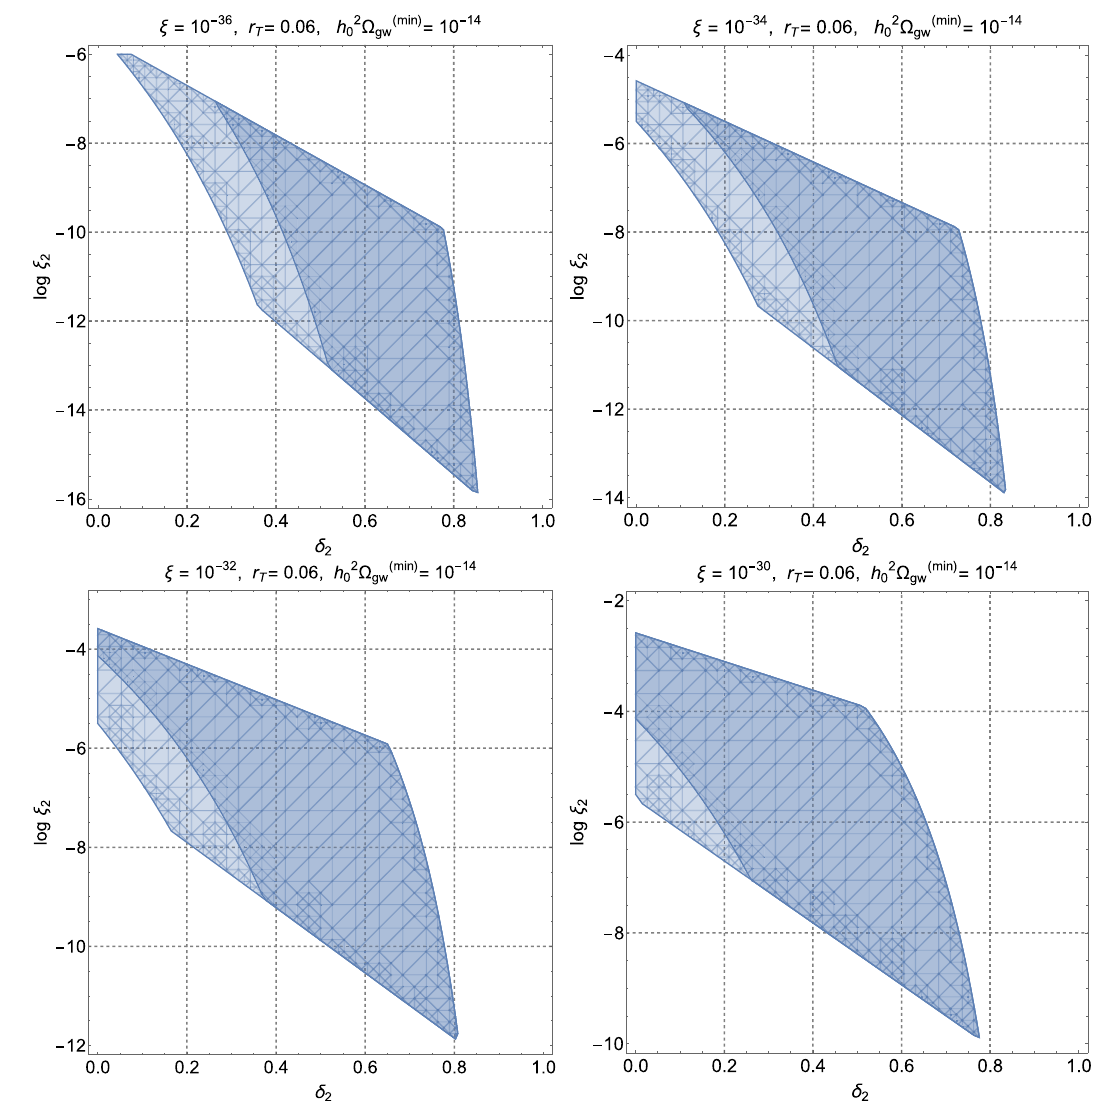
Fig. 3 As in Fig. 2 the parameter space of the model is illustrated in the plane (δ 2 , ξ 2 ) . The difference between these plots and the ones of Fig. 2 − 14 while it was 10 − 11 in Fig. (cid:4) ( min ) is related to h 2 g w which is now given by 10 0